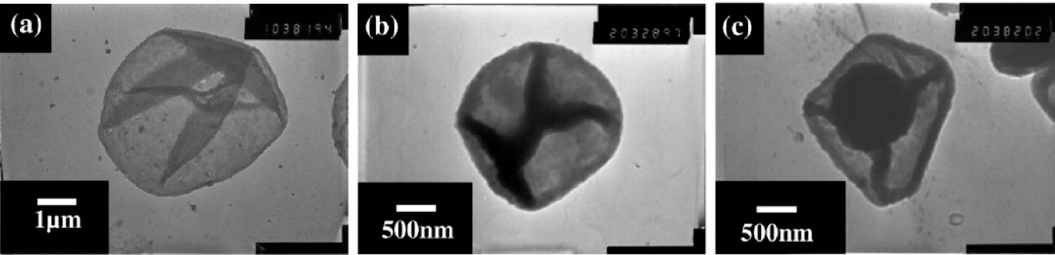
Figure 5. TEM images of ( a ) empty (PAH/PSS) 4 -PAH microcapsules, and those capsules loaded with ( b ) DNR and ( c ) DOX. Figure adapted with permission from Reference [93], copyright© 2006, Elsevier.